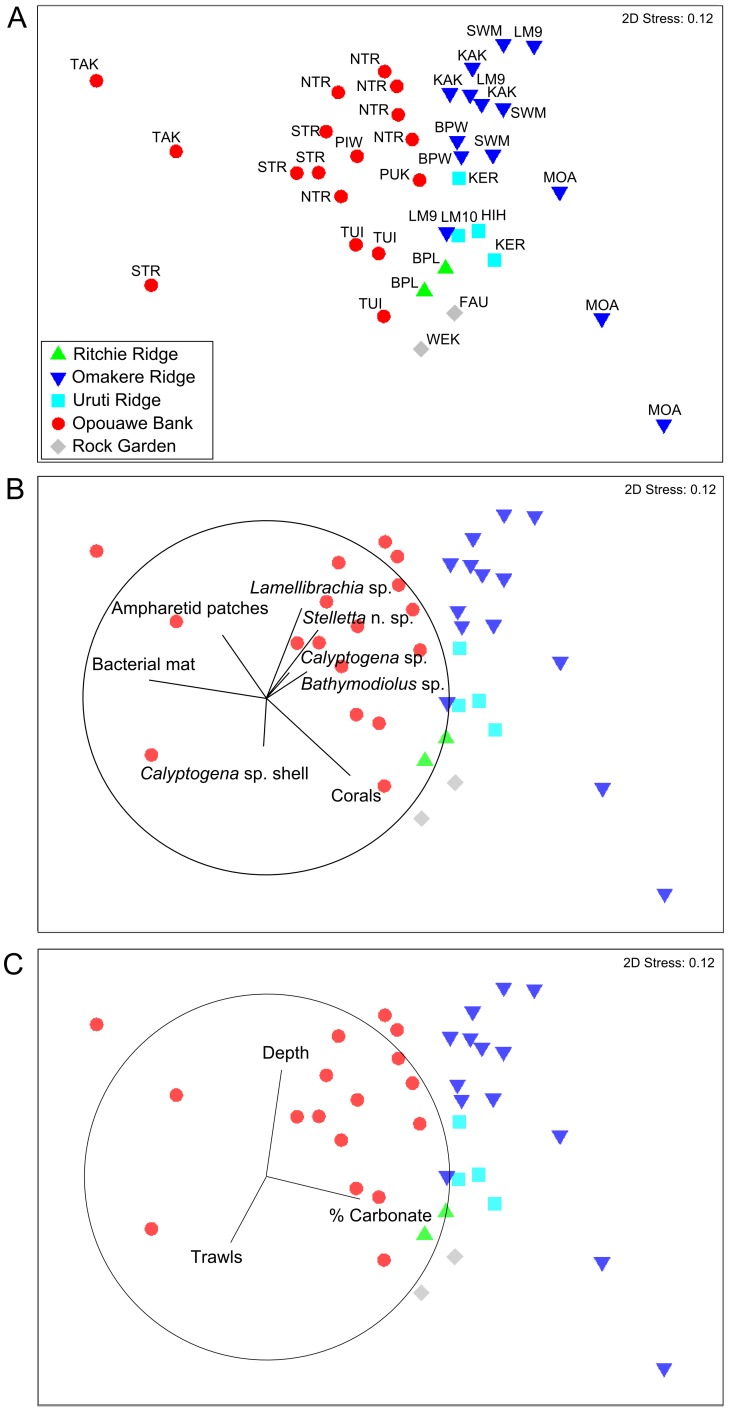
Non-metric multivariate scaling (NMDS) ordination of Hellinger distances between seep communities observed in video transects.Underlying data are log-transformed occurrence records of chemoautotrophic megafauna (Lamellibrachia sp. tubeworms, Calyptogena sp. clams, Bathymodiolus sp. mussels, Stelletta n. sp. sponges), seep-associated substrata (bacterial mats, ampharetid patches and Calyptogena sp. clam shells), and intact scleractinian coral matrix. A – Transects distinguished by region (symbols; see Figure 1 for context) and seep site (labels; see Table 1 for full names). B – Contributions (Pearson correlations) of faunal variables to between-sample distances. C – Relationships (Pearson correlations) between three environmental variables and the distribution of transects in the ordination: depth (−0.57); % carbonate rock substratum (0.52), and number of trawls per site from 1998 to 2005 (0.41).